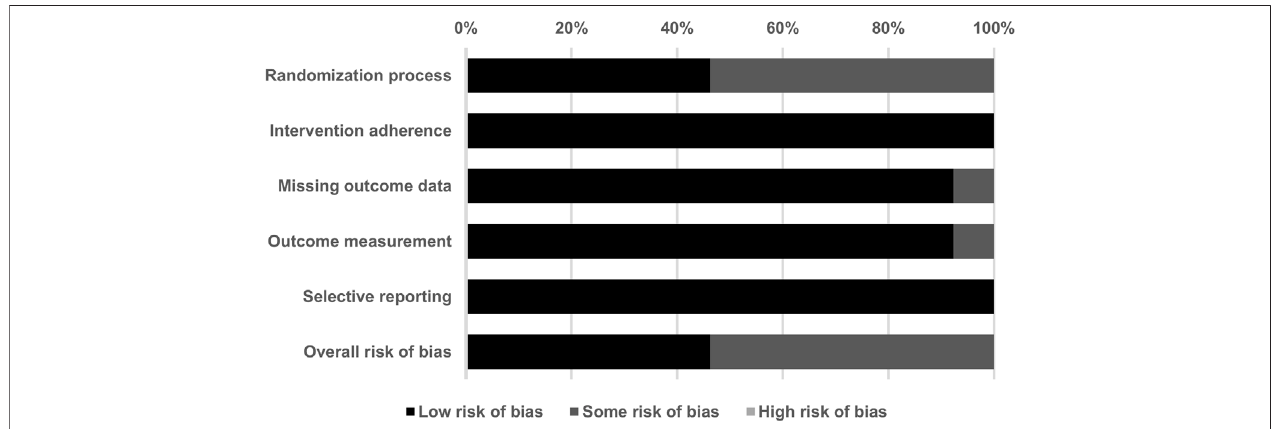
FIGURE 2 | Summary of quality assessment for the studies included in the current meta-analysis using version 2 of the Cochrane risk-of-bias tool for randomized trials.